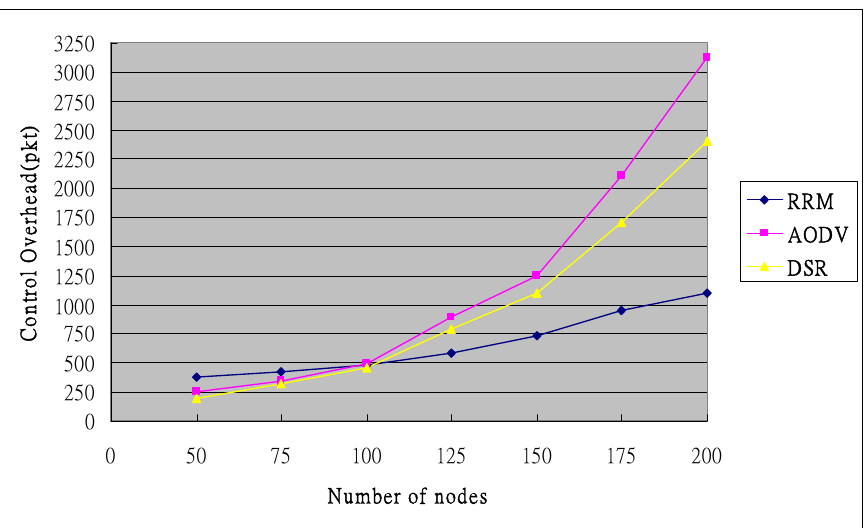
Figure 17. Control overhead.